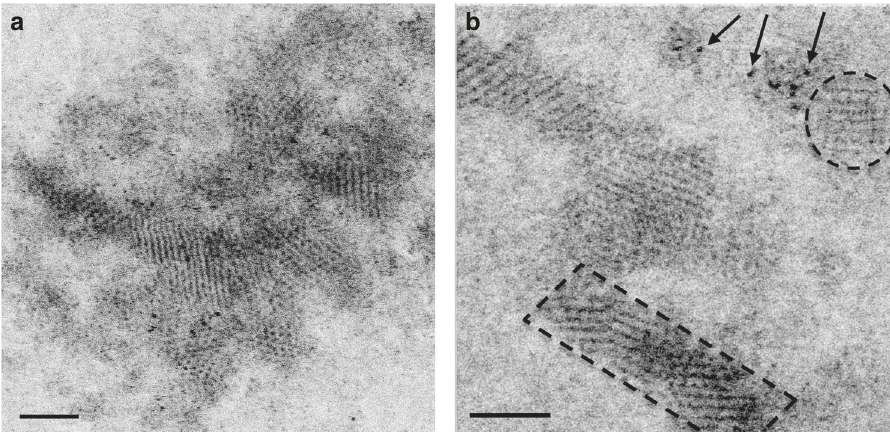
Fig. 6 Representative TEM images of nascent Mn oxide nanoparticles produced by Mnx. The reaction proceeded for 30 min at a substrate to enzyme molar ratio of 5000:1. a Agglomerated forms of nanoparticles (crystallites). Individual crystallites are ~1.1 – 4.2 nm in length, with an average diameter of 2.3 ± 0.7 nm. b Atomic resolution TEM revealed three distinct forms of nanocrystalline material: amorphous clusters consisting of individual Mn atoms (arrows), individual nanocrystals (dashed circle), and agglomerations of crystallites forming lath-like crystals (dashed rectangle — notice the MnO x atomic rows). Scale bars are 2